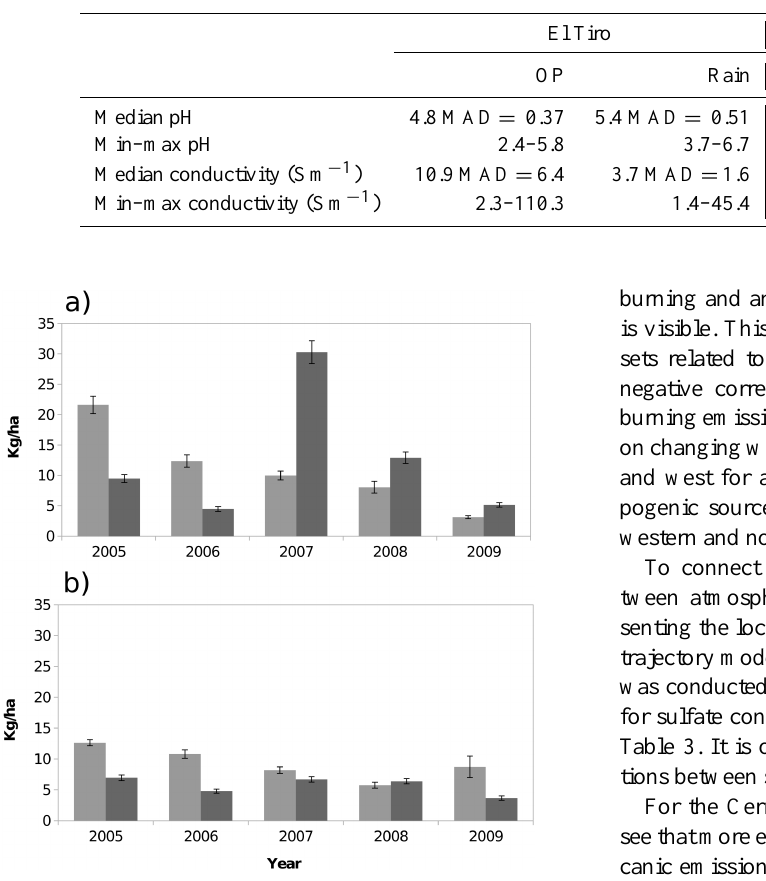
Table 1. pH and conductivity summary statistics in occult precipitation (OP) and rain samples from El Tiro and Cerro del Consuelo meteo- rological stations (MSs).